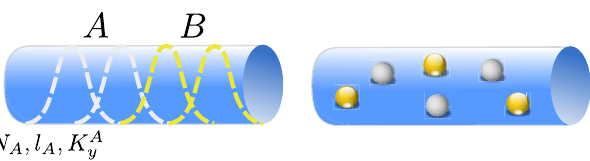
FIG. 7. Two choices of partitioning the system for computing the entanglement spectrum. The orbital cut (left diagram) amounts to partitioning the system into two groups of orbitals A and B , and tracing out the orbitals in B (marked yellow). The Schmidt levels of A can be classified by the number of particles N l K A A , the number of orbitals A , and the total momentum y . An alternative choice is particle partitioning (right diagram), where some particles (marked in yellow) are traced out, regardless of their